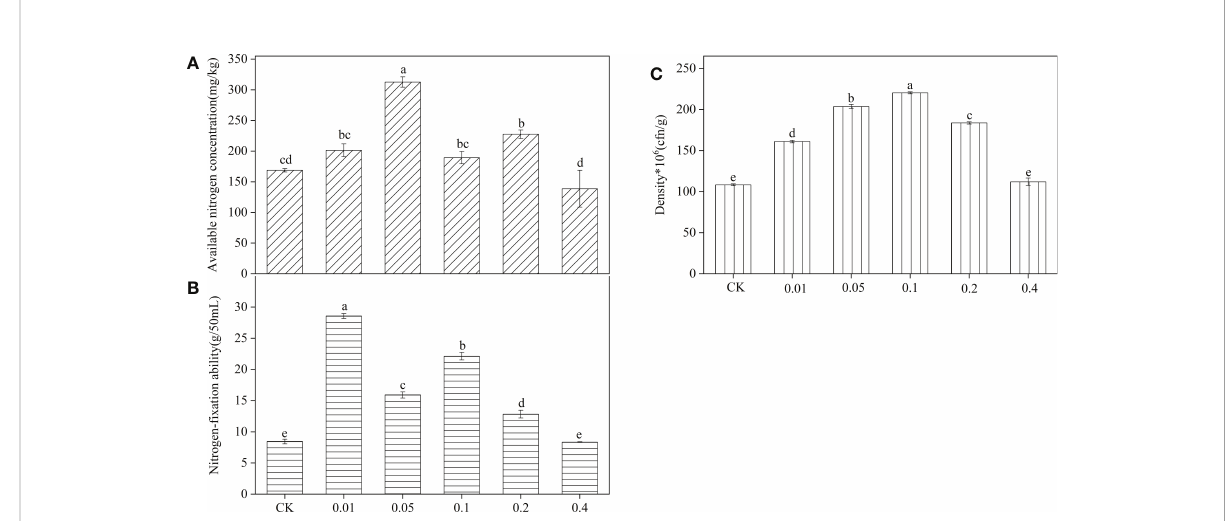
FIGURE 6 Effect of B . megaterium on soil available nitrogen after being treated with different concentration phenol treatments (A) , and the nitrogen- fi xation ability (B) and density (C) of B . megaterium . Different lowercase letters indicate that the same strain with different concentration of phenol treatments has signi fi cant differences at the P < 0.05 level. The “ * ” indicated that density of the Bacillus strains multiplied by 10 6 .